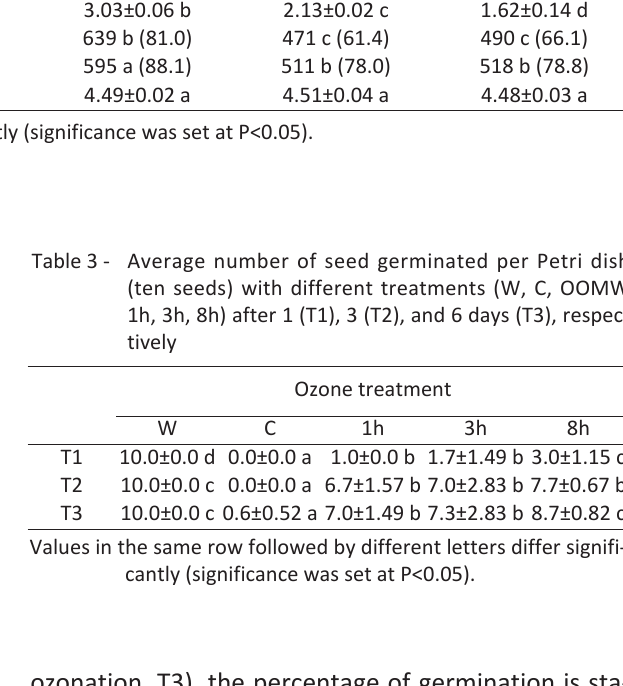
Table 2 - Analytical parameters collected after oxidative treatments of OOMW with ozone for 1, 3 and 8 hours